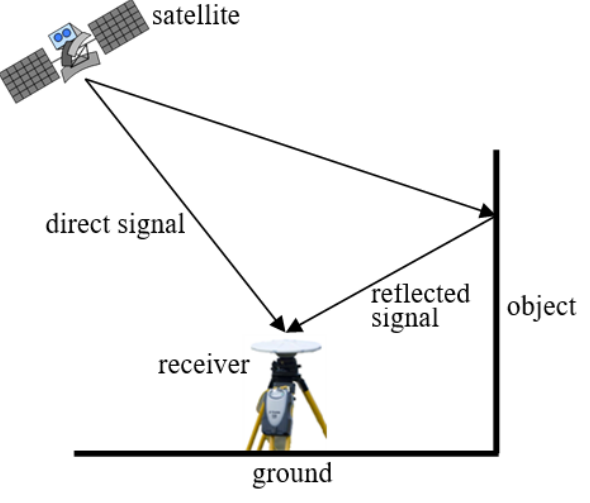
Figure 1. Principle of multipath.